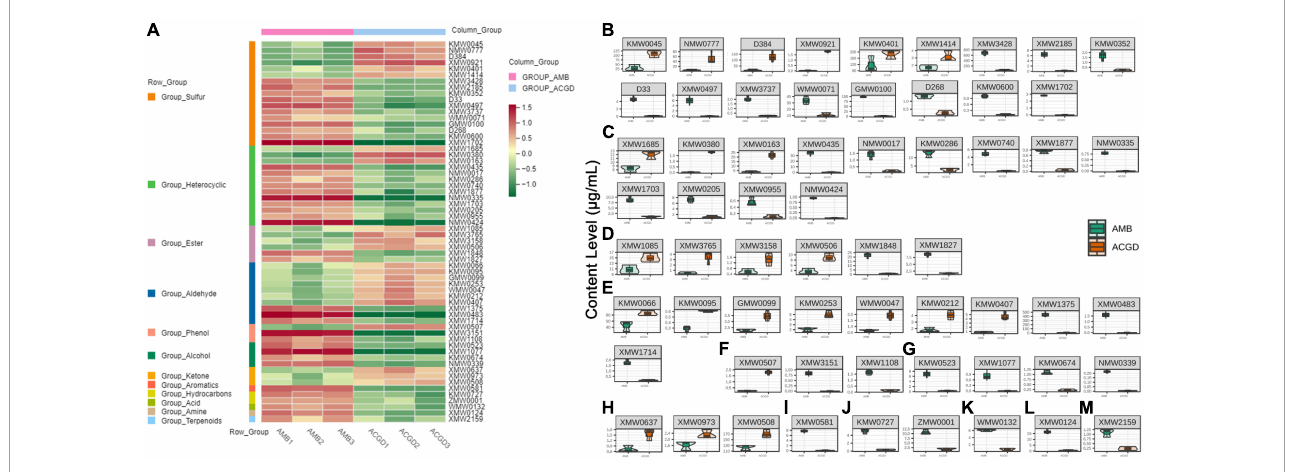
FIGURE8 The accumulation pattern of 62 differential volatile organic compounds (VOCs) between Allium macrostemon Bge. (AMB) and Allium chinense G. Don (ACGD) (A) , red color and green color represent up-accumulated and down-accumulated compounds, respectively; comparison of relative amounts of 62 differential VOCs including 17 sulfur compounds (B) , 13 heterocyclic compounds (C) , 6 esters (D) , 10 aldehydes (E) , 3 phenols (F) , 4 alcohols (G) , 3 ketones (H) , 1 aromatic (I) , 2 hydrocarbon (J) , 1 acid (K) , 1 amine (L) , and 1 terpenoid (M) in AMB and ACGD samples.